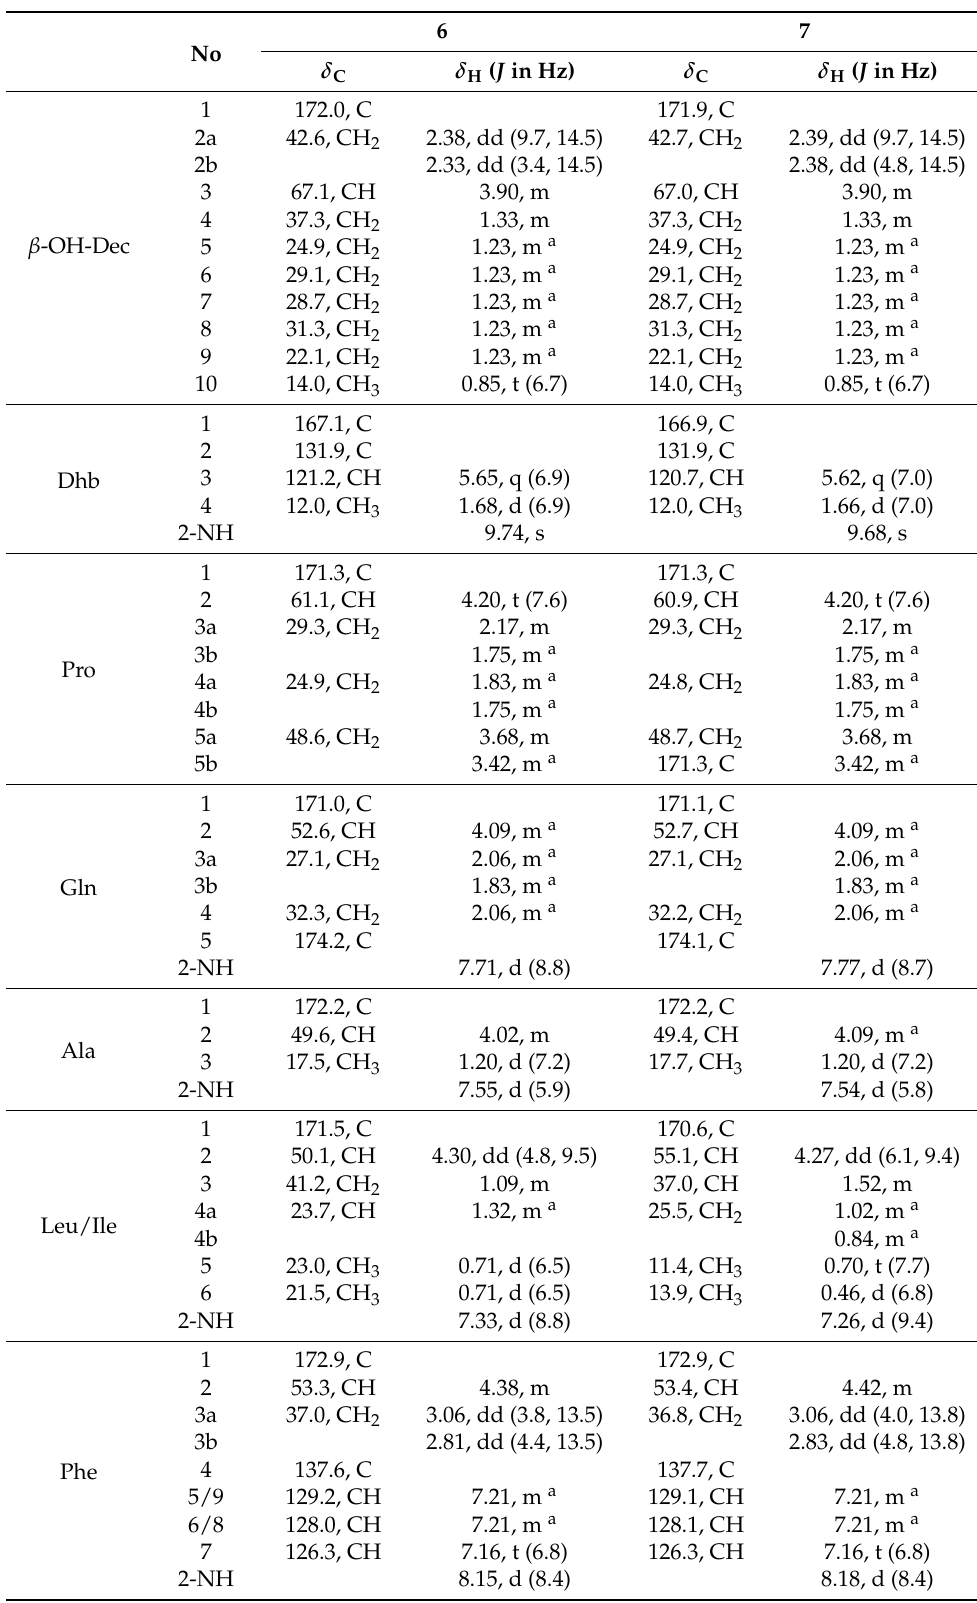
Table 4. The 1 H (500 MHz) and 13 C NMR (125 MHz) data of 6 – 7 in DMSO- d